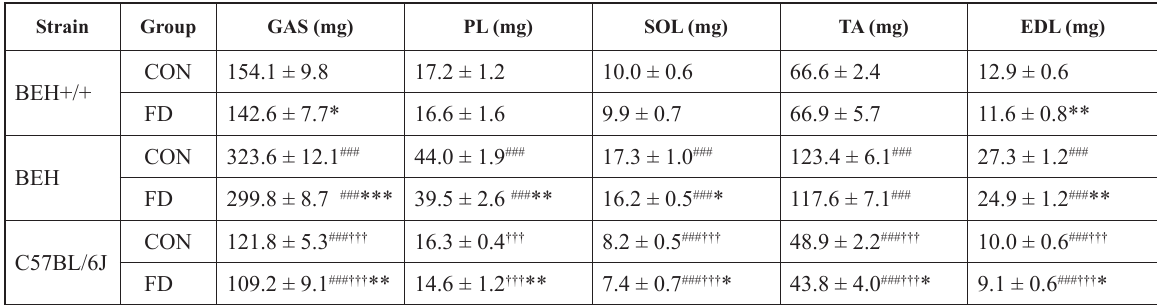
Table. Muscle mass for BEH+/+, BEH and C57BL/6J mice from the control (CON) and food deprivation (FD) groups Strain